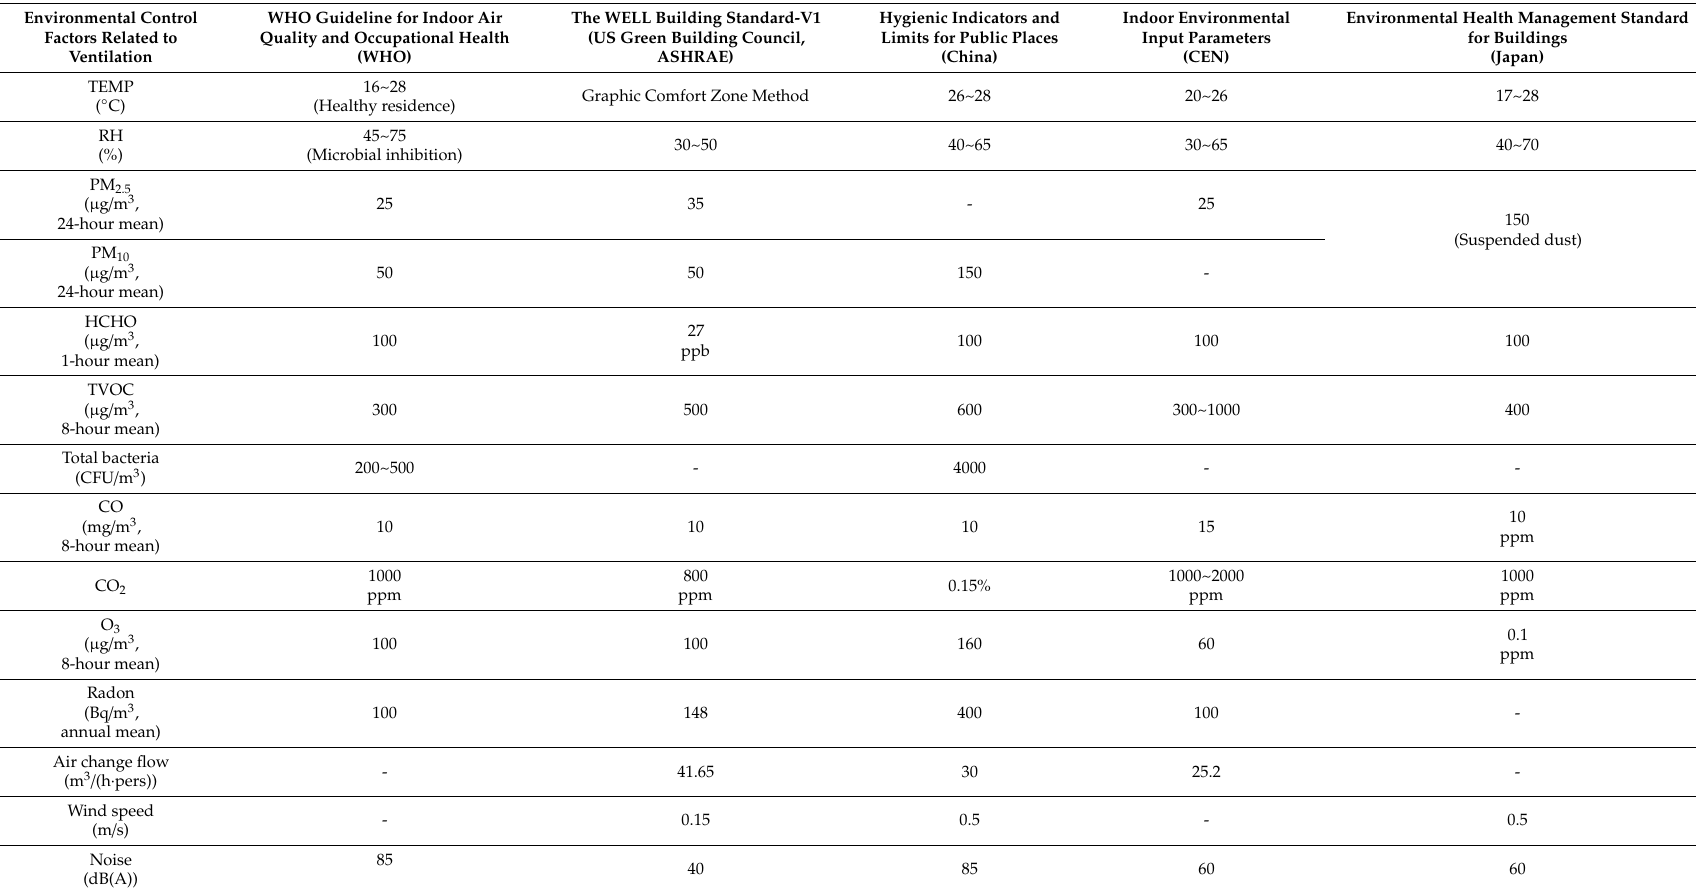
Table 5. Environmental control indices of relevant standards or